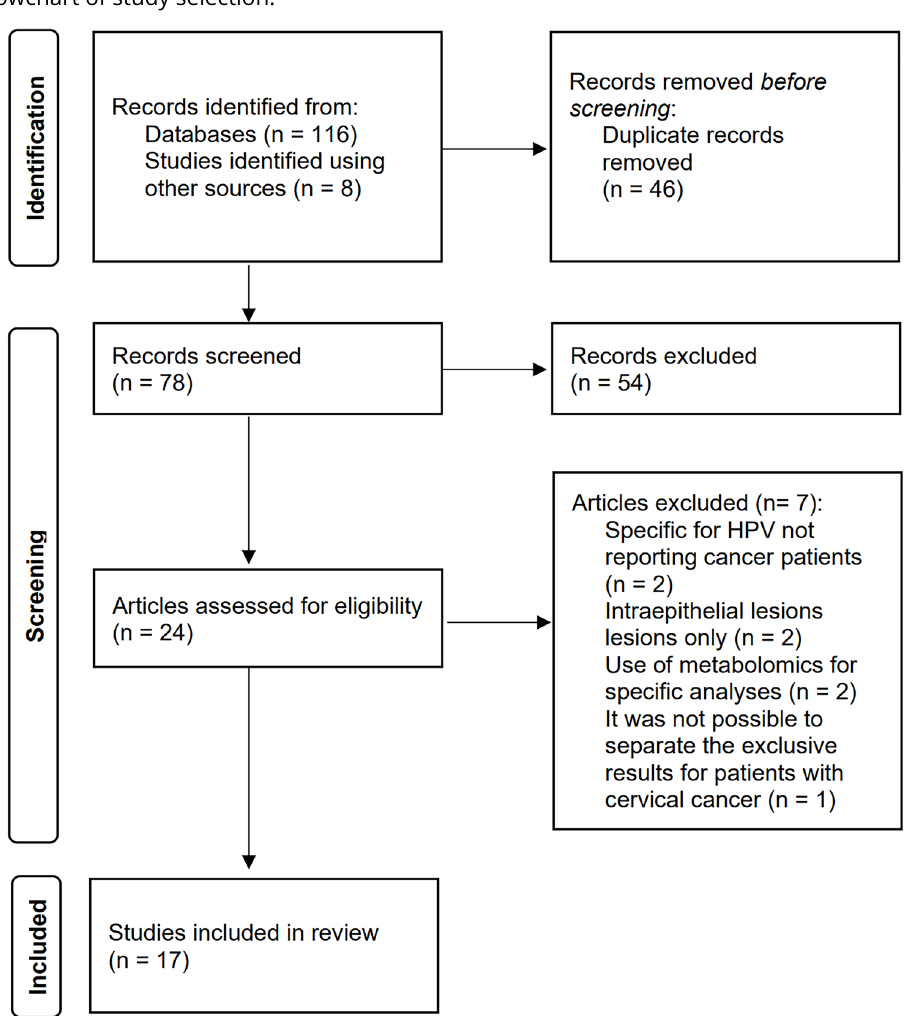
Figure S1 – Flowchart of study